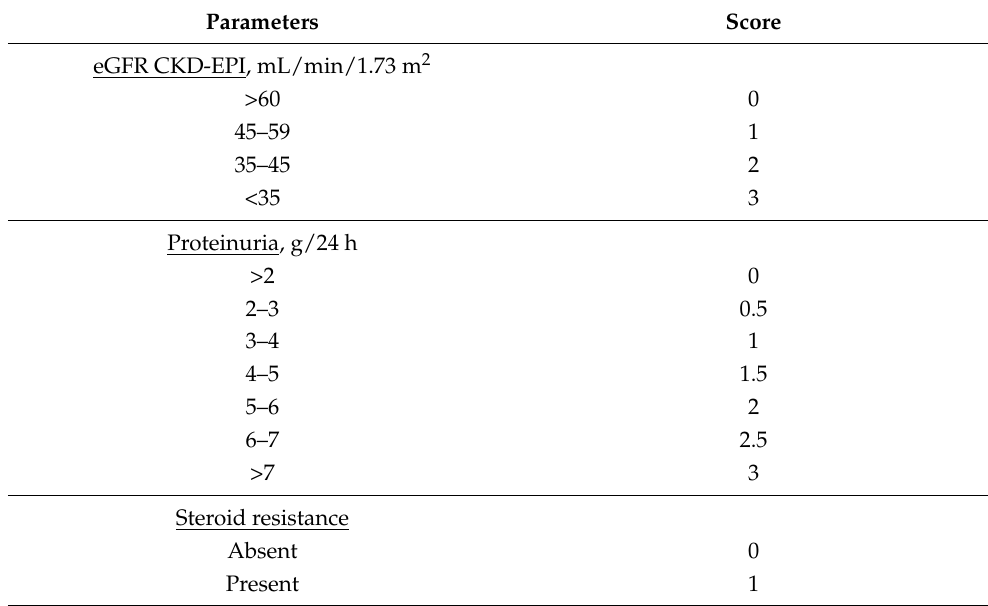
Table 4. Calculation of the FSGS severity